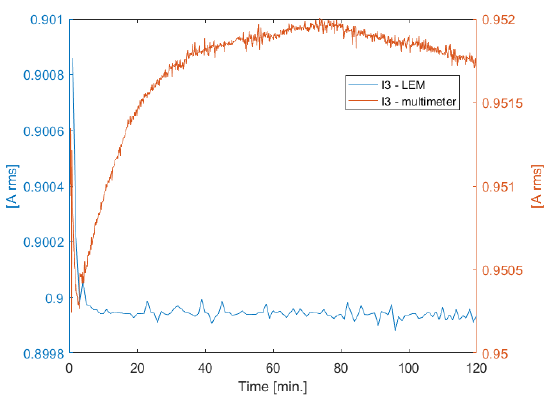
Figure 3. Voltage drift vs time; current loop turned on.